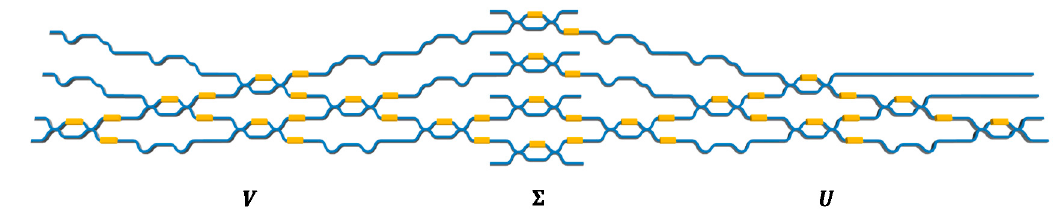
Figure 8. MZI mesh can be designed to mimic arbitrary n × n complex-valued matrix utilizing SVD.